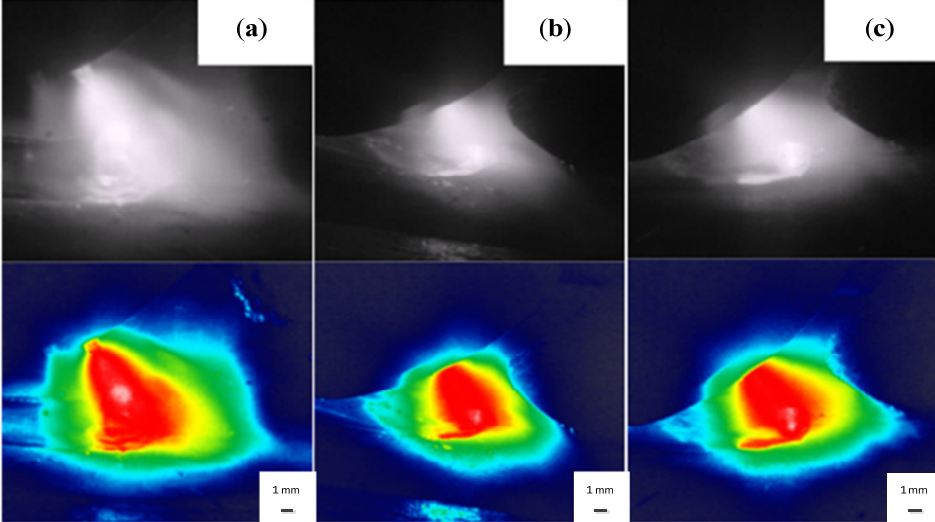
Figure 6. Schematic diagram of laser K-TIG hybrid arc profile at different distance between heat sources: ( a ) 2.5 mm, ( b ) 3.5 mm, ( c ) 4.5 mm.